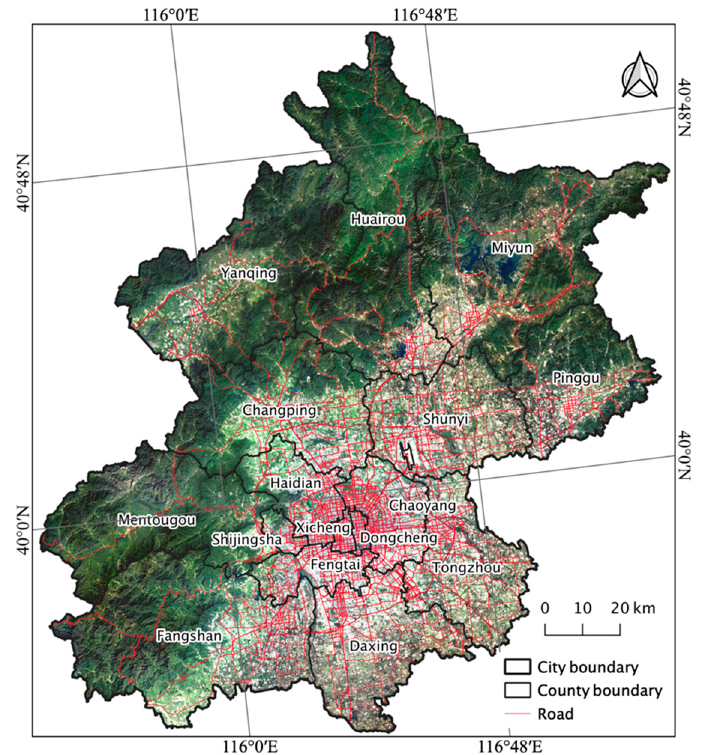
Figure 1. Map of the study area. The background is a natural color composite image displaying a combination of the visible red, green, and blue band of satellite imagery. The satellite imagery used here is Landsat 8 Operational Land Imager (OLI) 30 m images [46] .